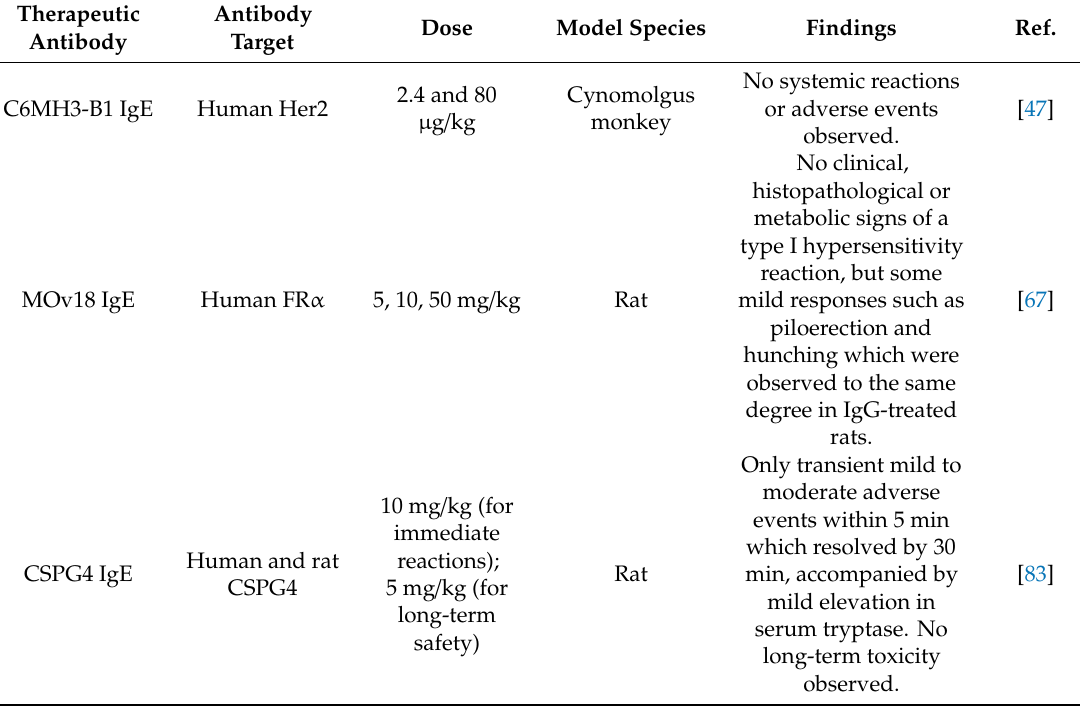
Table 3. In vivo safety and toxicity evaluations of therapeutic IgE